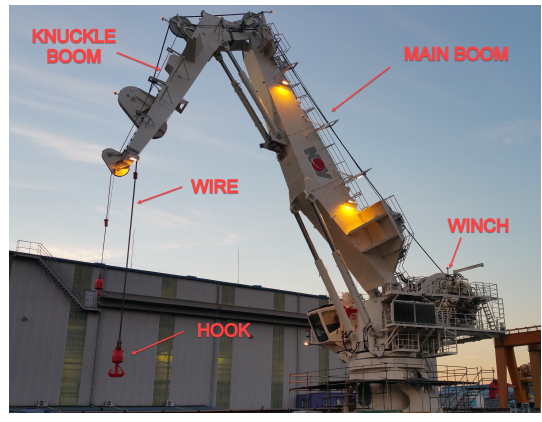
Figure 1: Typical knuckle boom crane design.